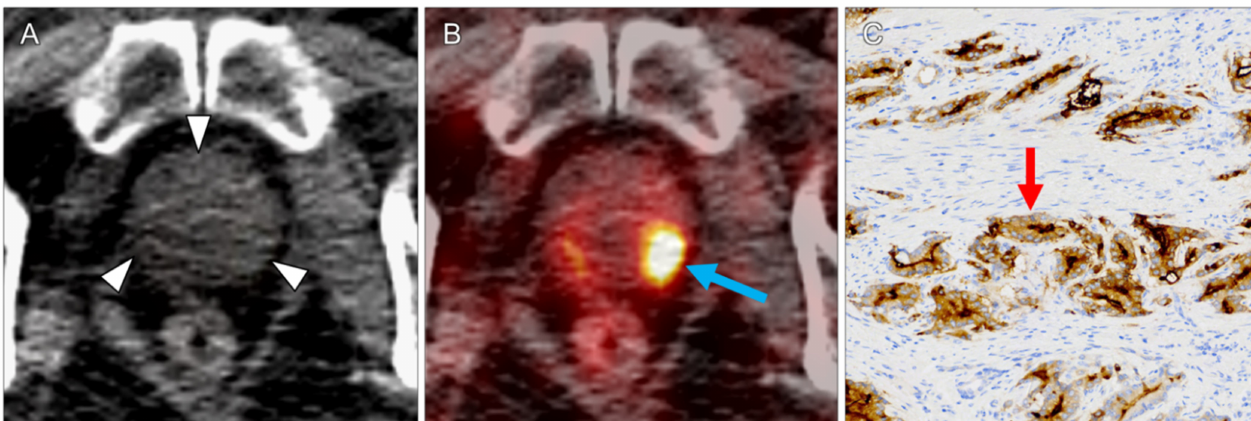
Figure 4. Incidental finding of a prostate carcinoma (lesion 3) in a patient who also had pulmonary and lymph node ccRCC metastases. On non-enhanced CT, the prostate appeared unremarkable (( A ), arrowheads). PET/CT revealed high focal tracer uptake in the left peripheral zone (( B ), arrow; SUVmax 9.3). In the biopsy-proven prostate carcinoma, strong PSMA expression on the cytoplasmatic membranes was seen (( C ),